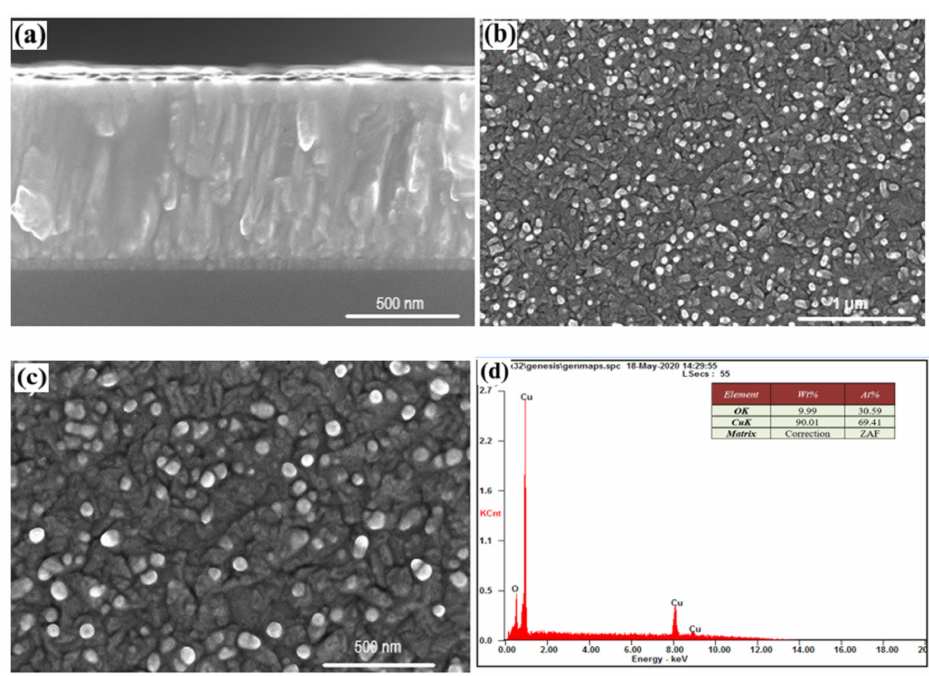
Figure 4. Cross-section ( a ), morphology ( b , c ), and chemical analysis ( d ) of sample #13. In sample #15, the growth of the columns is seen developing in the same direction of the preferred orientation of the c-axis (Figure 5a). The observed structure resembles a continuous film with vertical chips along the direction of growth (Figure 5b,c).